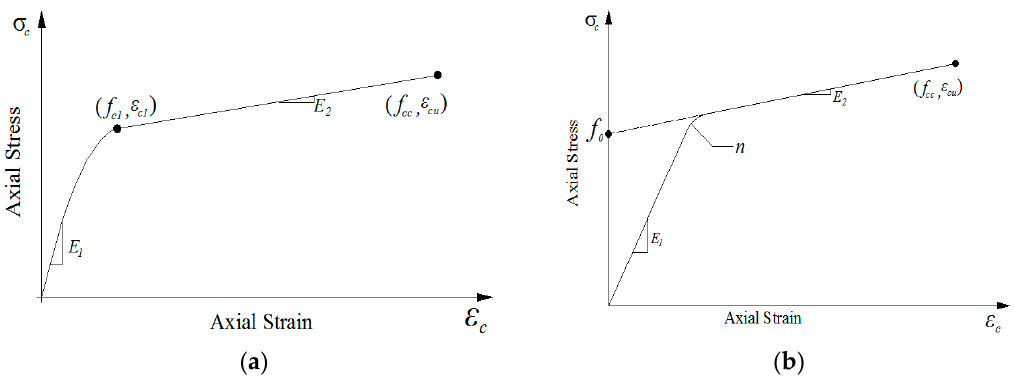
Figure 9. The representative stress–strain models. ( a ) Piecewise function; ( b ) Single function. Table 11. Stress–strain models of FRP-confined concrete.